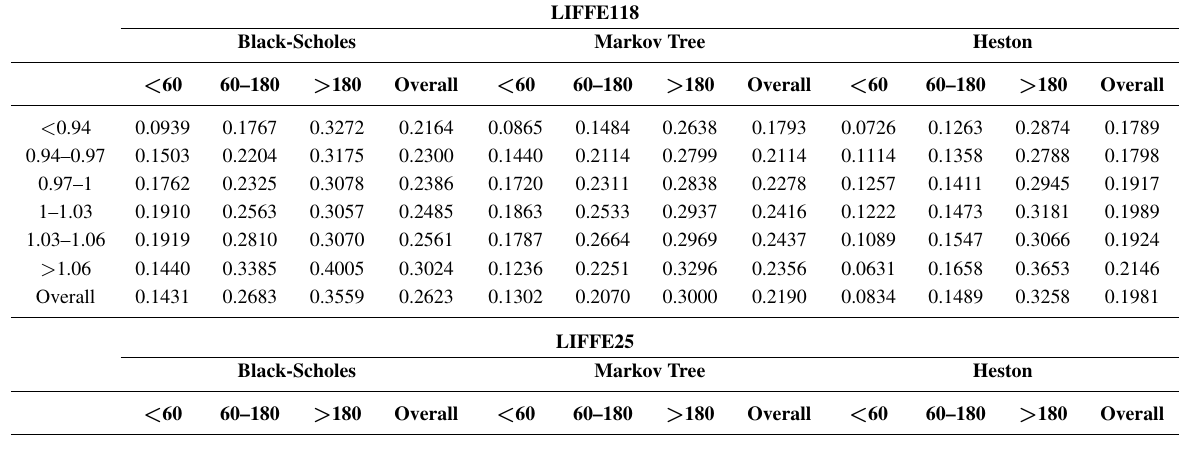
Table 5. For each of four data sets (in boldface), we present in-sample pricing errors for the three models studied in Section 6.1: the Black-Scholes model, the MT model, and Heston’s model. All three models are fit to data using overconstrained L 2 regression procedures. The out-of-sample pricing errors corresponding to these tables are given in Table 7. This table corresponds to the discussion of in-sample errors in Section